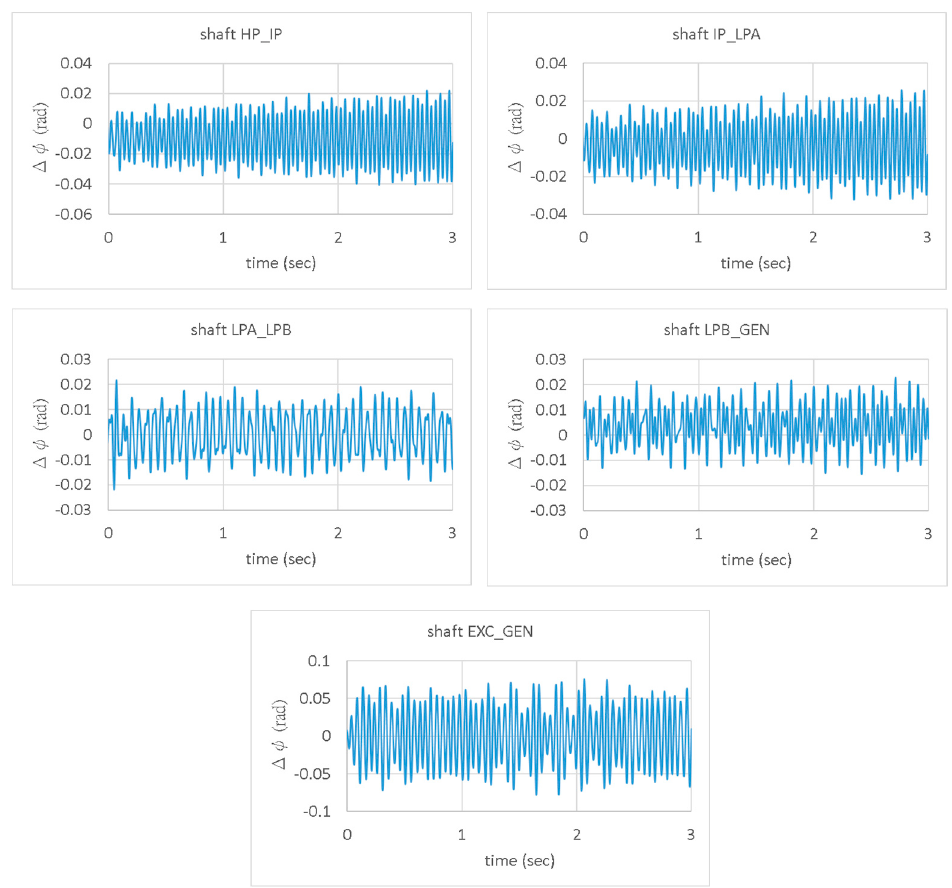
Figure 22. Turbine shaft transient responses with MOV for the incorporation of PMSG wind farm.